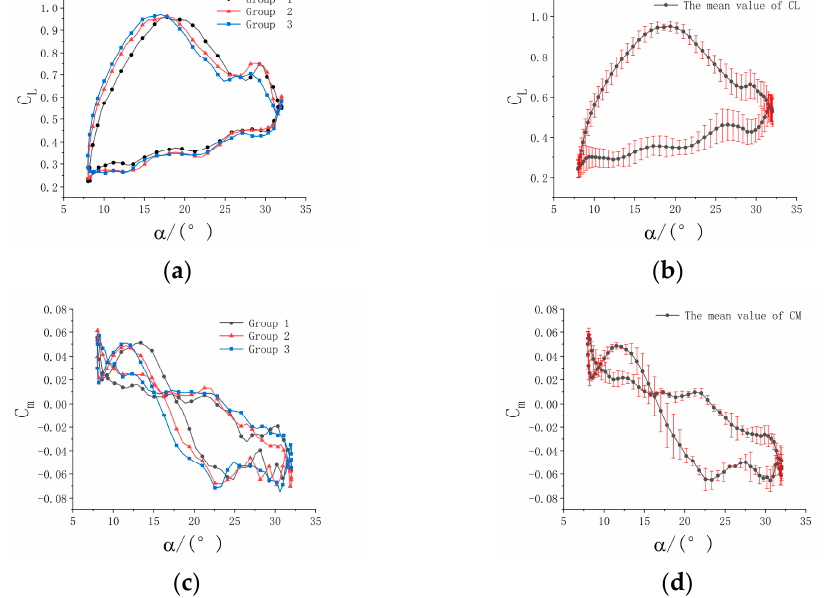
Figure 10. Comparison of three sets of dynamic experimental data at reverse-blowing. ( a ) Three sets of lift coefficient curves, ( b ) lift factor error bars, ( c ) three sets of moment coefficient curves, and ( d ) moment coefficient error bars.